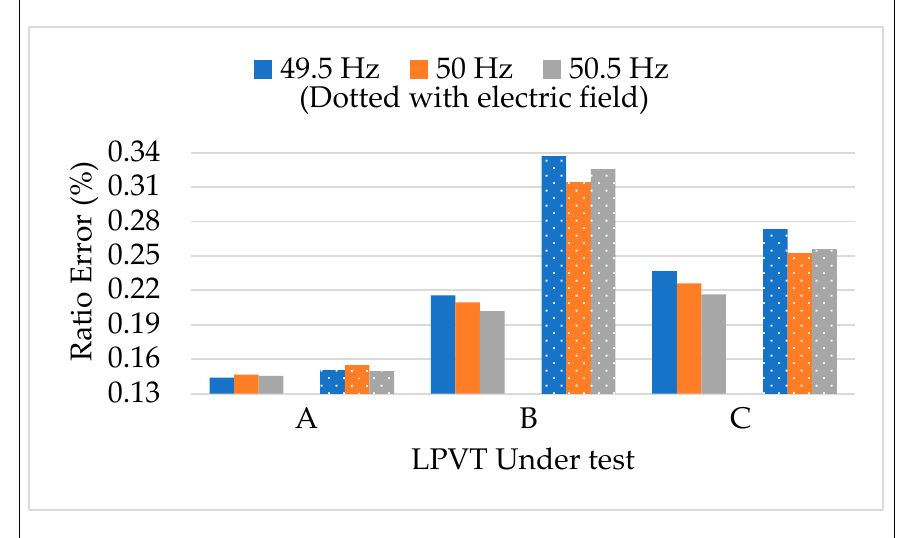
Figure 11. Ratio error vs. frequency + electric field for the three LPVTs under test.